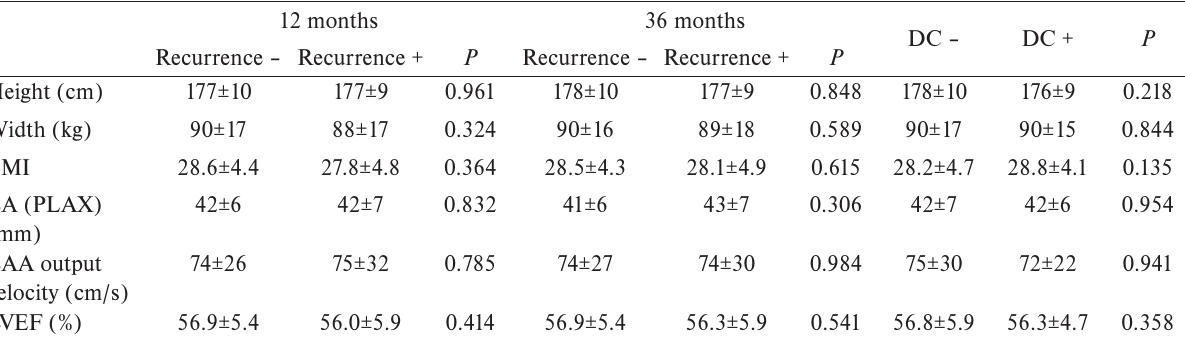
Table 3. The difference in height, width, body-mass index and in echocardiographic parameters performed 1-24 h before abla- tion in patients with and without arrhythmia